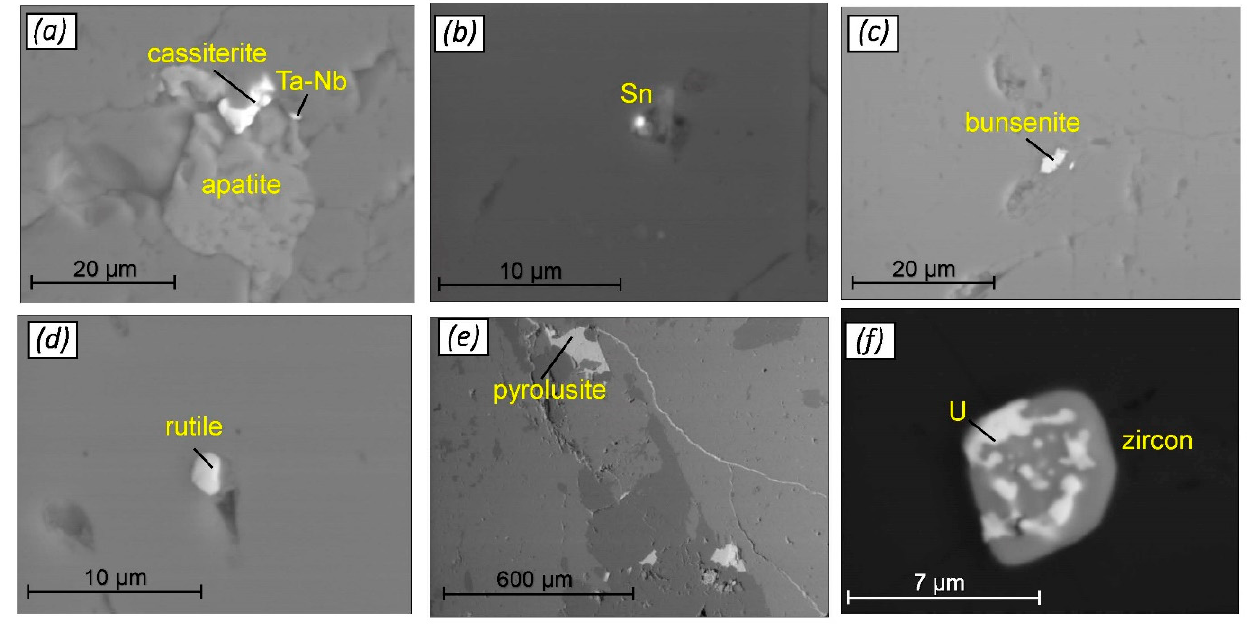
Figure 9. Micrometer mineral inclusions in albite pegmatites with spodumene (sample TO-13, TO-12). ( a ) Cassiterite and tantalite–columbite in apatite; ( b ) native tin; ( c ) Ni phase (bunsenite?); ( d ) rutile; ( e ) Mn phase (pyrolusite); ( f ) zircon with disseminated U phase (uraninite).